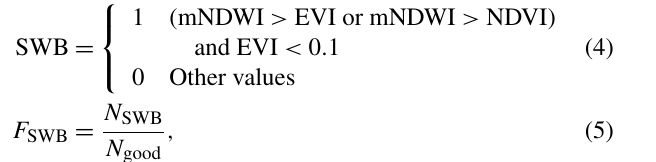
tributes from ICOLD. GeoDAR v1.1 consists of (1) dam